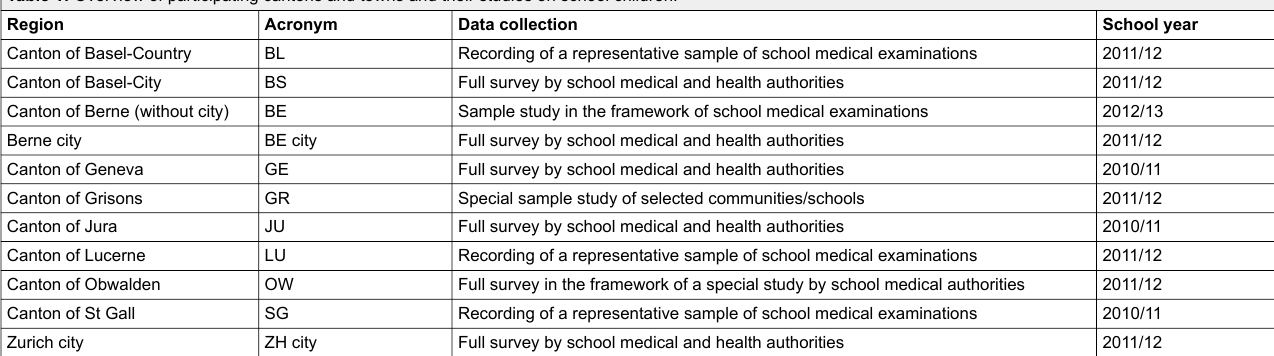
Table 1: Overview of participating cantons and towns and their studies on school children. Region